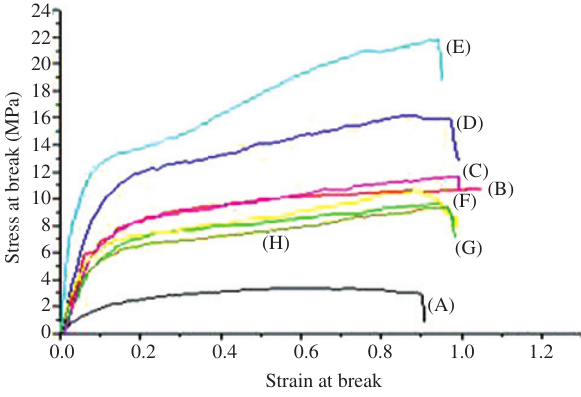
Figure 7: Stress-strain curves of PVA/( x )MWCNTs(15- x )ZnO